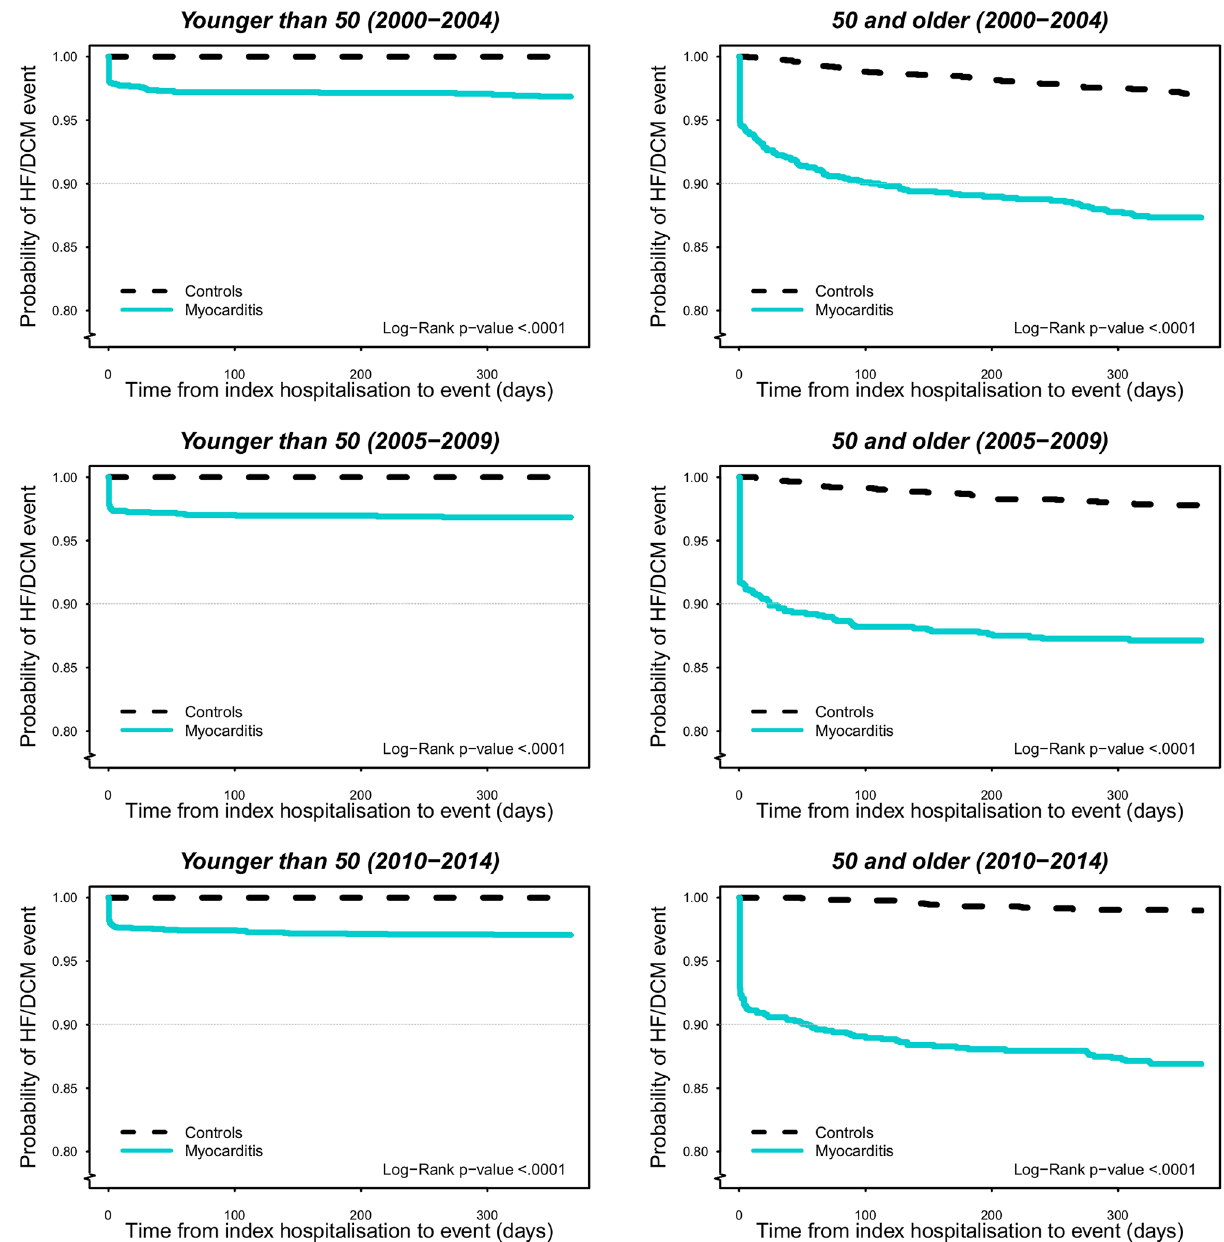
Figure 3. Probability of event heart failure/dilated cardiomyopathy 1 year after hospitalization from 2000 to 2014 stratified by age: < 50 and ≥ 50